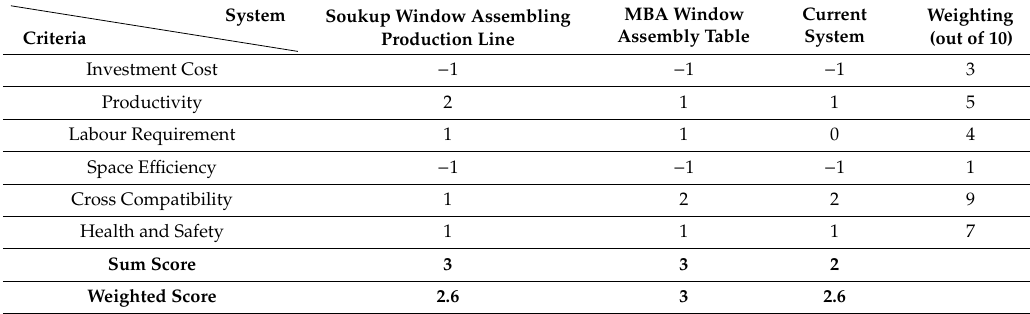
Table 8. Resultant scores for window